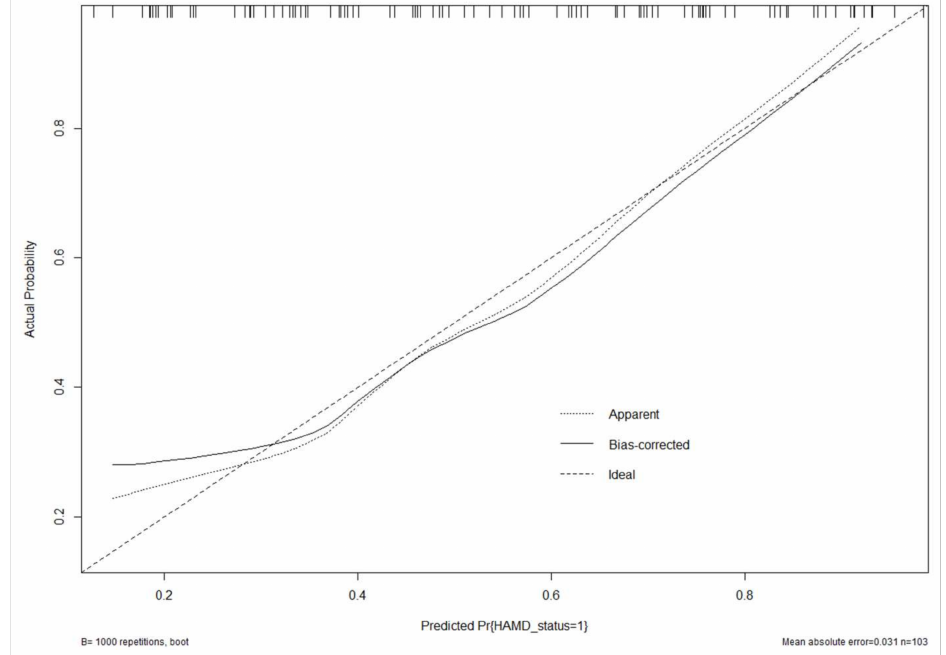
Figure A4. Calibration curve of the model. The calibration of the model in line with the agreement between predicted and observed outcomes of improvement of HAMD